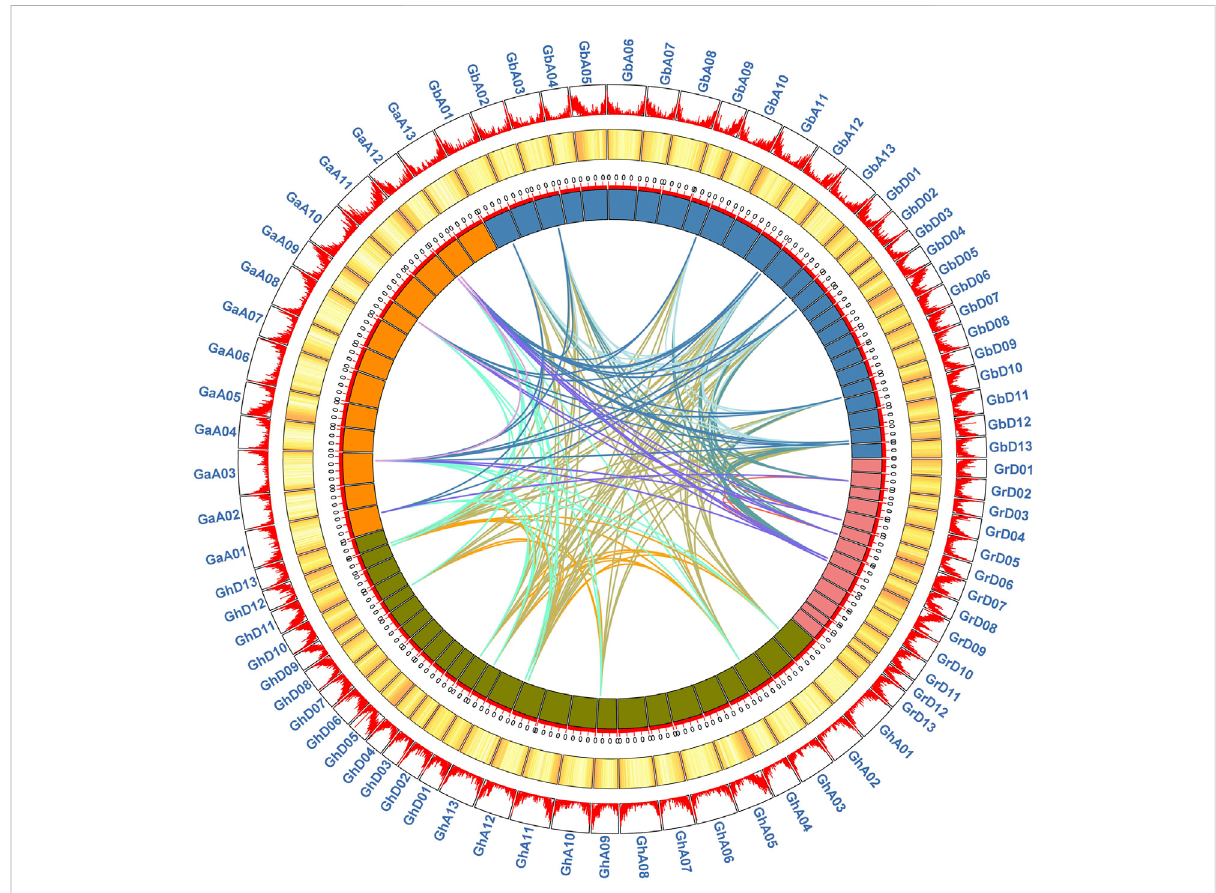
FIGURE 4 Syntenic relationship of duplicated genes pairs of GADs from four Gossypium ( G. hirsutum , G. barbadense , G. arboreum, and G. raimondii ). Chromosomal lines represented by various colors indicate the syntenic regions around the GADs. The heatmap and line map of the outer ring represents the density of genes on